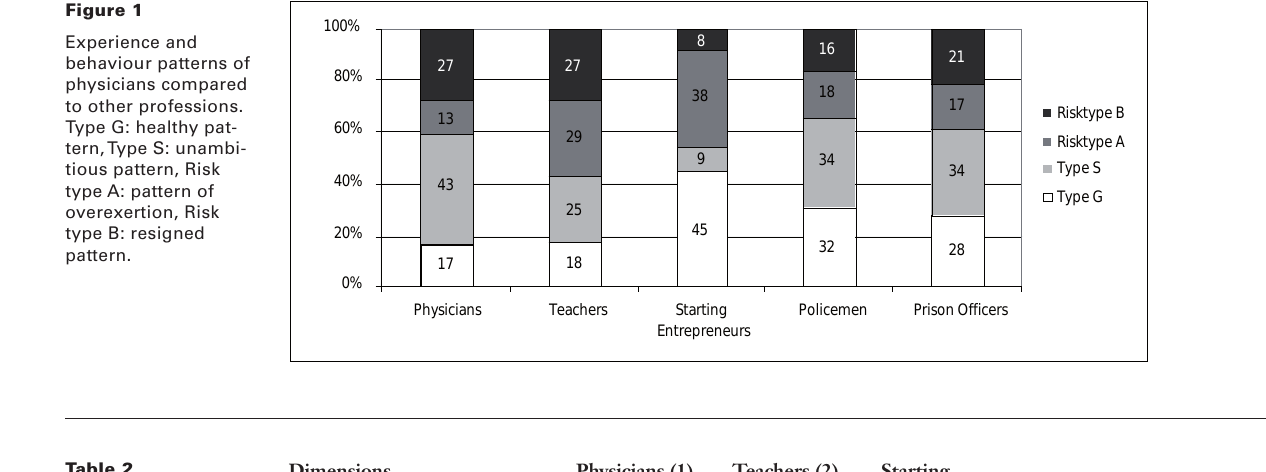
Table 2 Health-related dimen- sions in physicians compared to other professions. Highest scores are marked bold, lowest in